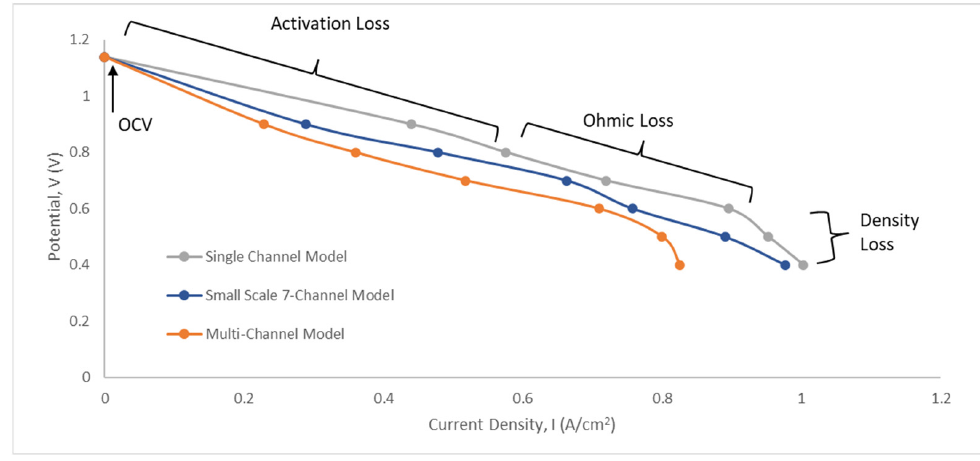
Figure 4. Polarization curves of single-channel, small-scale seven-channel, and multi-channel [26] models.